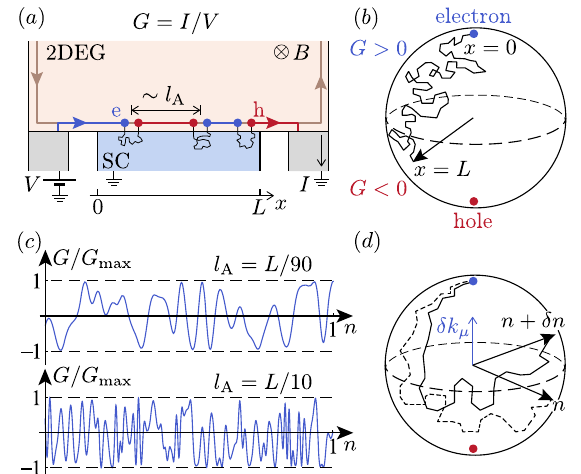
Fig. 1 | Transport along the quantum Hall edge proximitized by a disordered superconductor. a Electrons arelaunchedtoward the proximitized segment from an upstream electrode biased by voltage V . An electron propagating along the segment converts randomly into a holeover the distance l A , which is controlledby disorder in the superconductor, see Eq. (8). b Evolution of the electronic wave function, see Eq. (10), is similar to the motion of a “ spin ” in a stochastic effective “ magnetic fi eld ” . The conductance G = I / V is determined by the result of a random walk of a point on a Bloch sphere. c G is a random quantity that fl uctuates upon varyingtheelectrondensity n inthe2DEG(tracesaresimulatedusingEq.(10);units of n are the same for the two plots and are otherwise arbitrary). d The loss of correlation between the values of G upon a change in n is quanti fi ed by function C ð δ n Þ , see Eqs. (15) – (17). The origin of the correlations loss is illustrated by the divergence between two stochastic trajectories on a Bloch sphere. The “ spins ” corresponding to different values of n experience a different effective “ magnetic fi eld ” ,andthusdriftapartinthecourseofevolution.Theseparationofthe “ spins ” is slower for stronger disorder. As the result, the trace G ( n ) in ( c ) is smoother for smaller